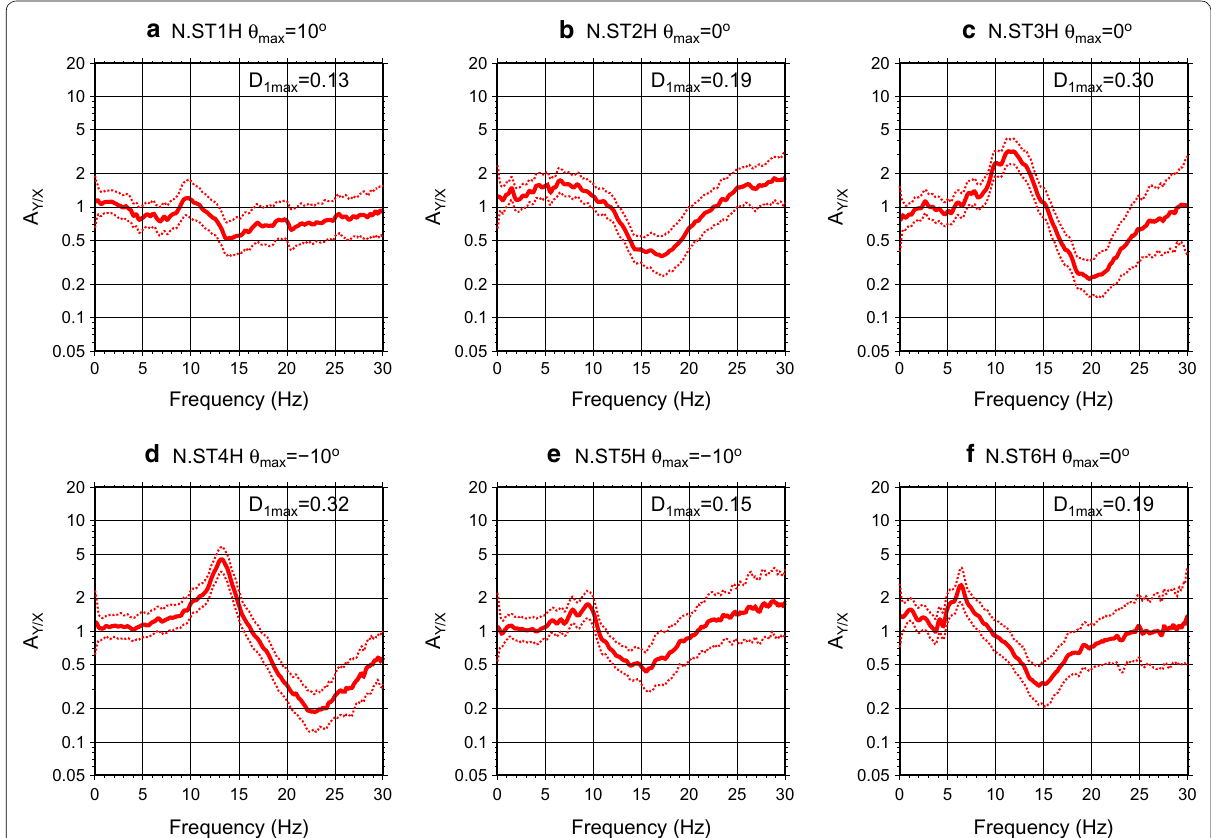
θ max ° obtained for six =